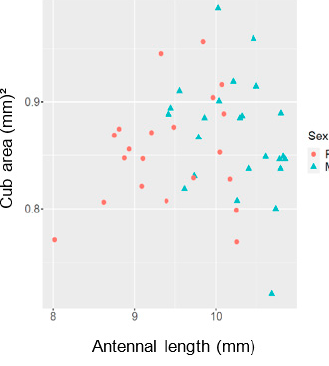
Figure A2. The relationship between club area and antennal stalk length in females (red circles) and males (blue triangles) of Pieris napi .